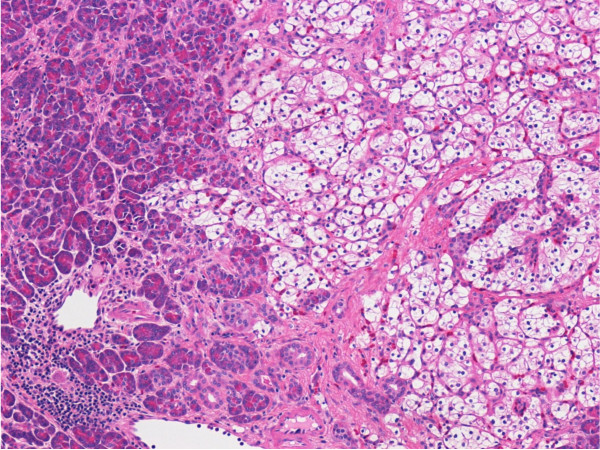
Histopathological evaluation. A histological examination of the distal pancreas from pancreatectomy showing metastatic renal cell carcinoma, clear cell type. A high-power view (Hematoxylin and eosin, 100×) showed tumor cells are characterized by epithelial cells with clear cytoplasm and a well-defined cell membrane, interspersed within a highly vascularized stroma.